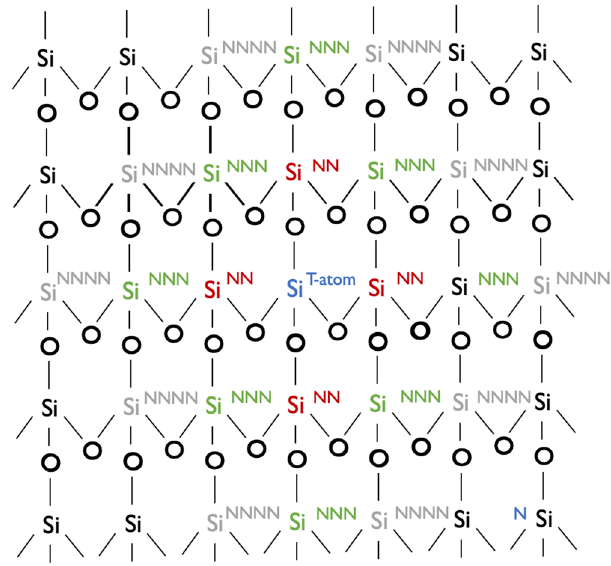
Fig. 2 Schematic illustration of atomic positions relative to a tagged Si T − atom (in blue). The Si T − atom is replaced with an Al atom to generate a univalent structure. For divalent structures, Si NN (in red), Si NNN (in green), and Si NNNN (in gray) atoms are identi fi ed. Candidate Al pair structures are generated by replacing one of the Si NNN or Si NNNN atoms, and the reference Si T − atom atom with Al unique T-site (Si T − atom ). Based on the connectivity of the Si T − atom , its NN Si atoms are identi fi ed (Si NN ). The Si atoms in NNN (Si NNN ) are identi fi ed by fi nding the next neighbors of Si NN (excluding the original Si T − atom and Si NN ). Each NNN Al pair is generated by replacing the Si T − atom and one of the Si NNN with Al atoms. For the NNNN Al pairs, the next neighbor of the Si NNN atoms are identi fi ed (Si NNNN ) (excluding Si T − atom , Si NN and Si NNN ). Similarly, the Si T − atom and each one of the Si NNNN atoms